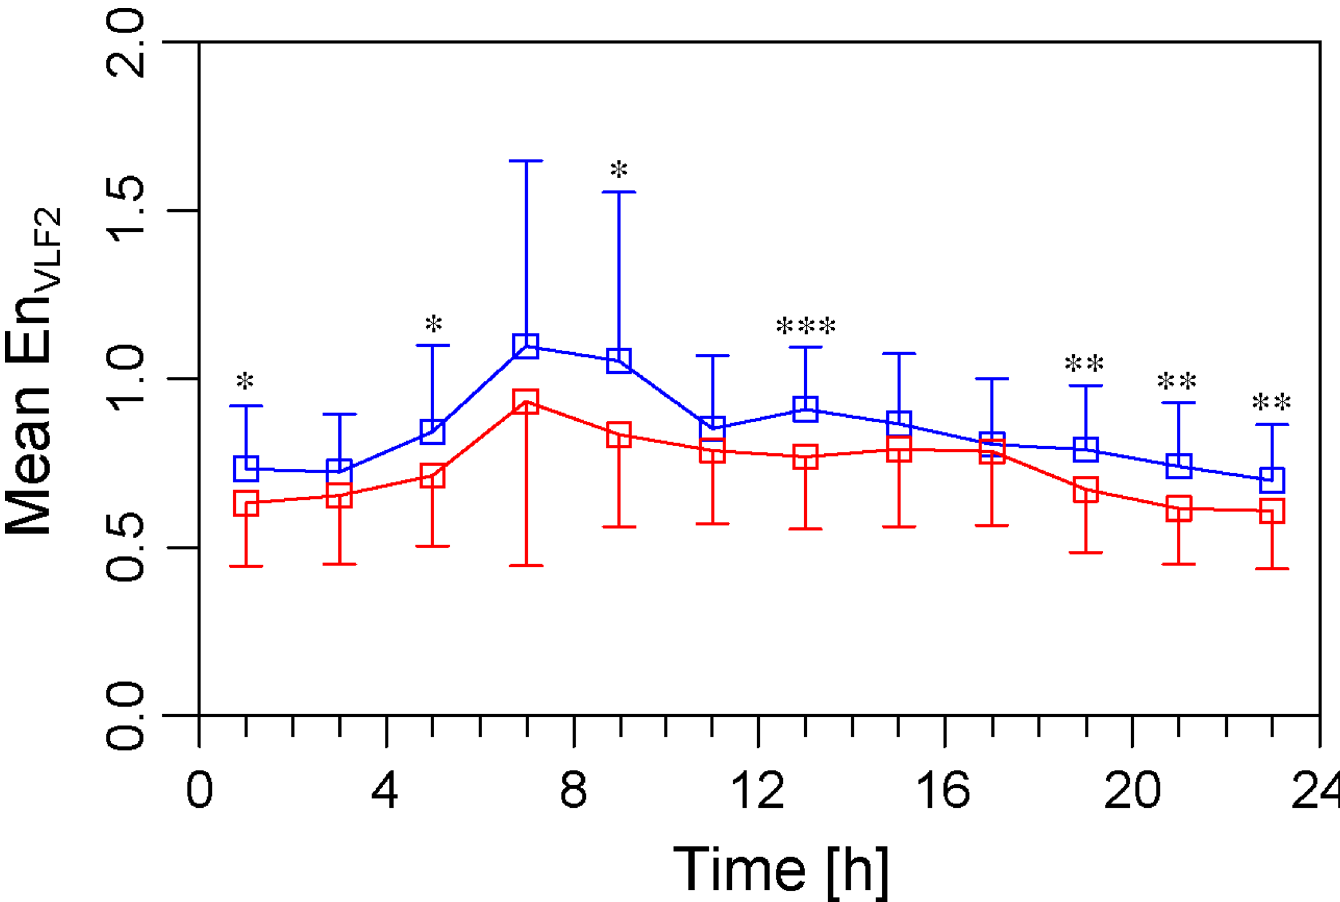
Fig 3. Diurnal variation in the sample entropy in the VLF2 subrange. The MeanEn VLF2 for a 4-hour period was plotted every 2 hours, where the center of the interval was assigned as the time. The blue rectangles denote the patients with incident ischemic strokes and the red rectangles denote the patients that did not develop ischemic strokes. MeanEn VLF2 : mean value of sample entropy of the very-low frequency range 2 (90 – 300